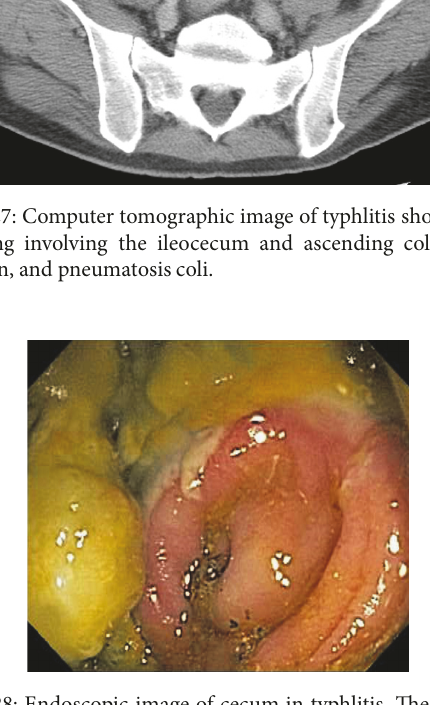
Figure 28: Endoscopic image of cecum in typhlitis. The appendix and periappendiceal mucosa are spared from ischemia and ulcera- tion. Pneumatosis coli is seen on the left.